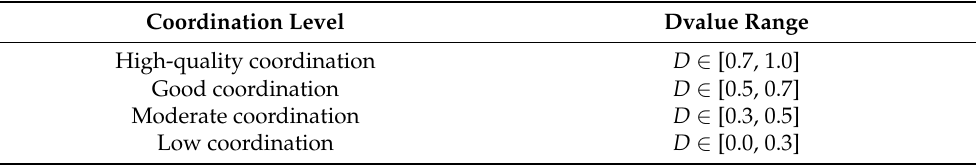
Table 4. Classification of coordination